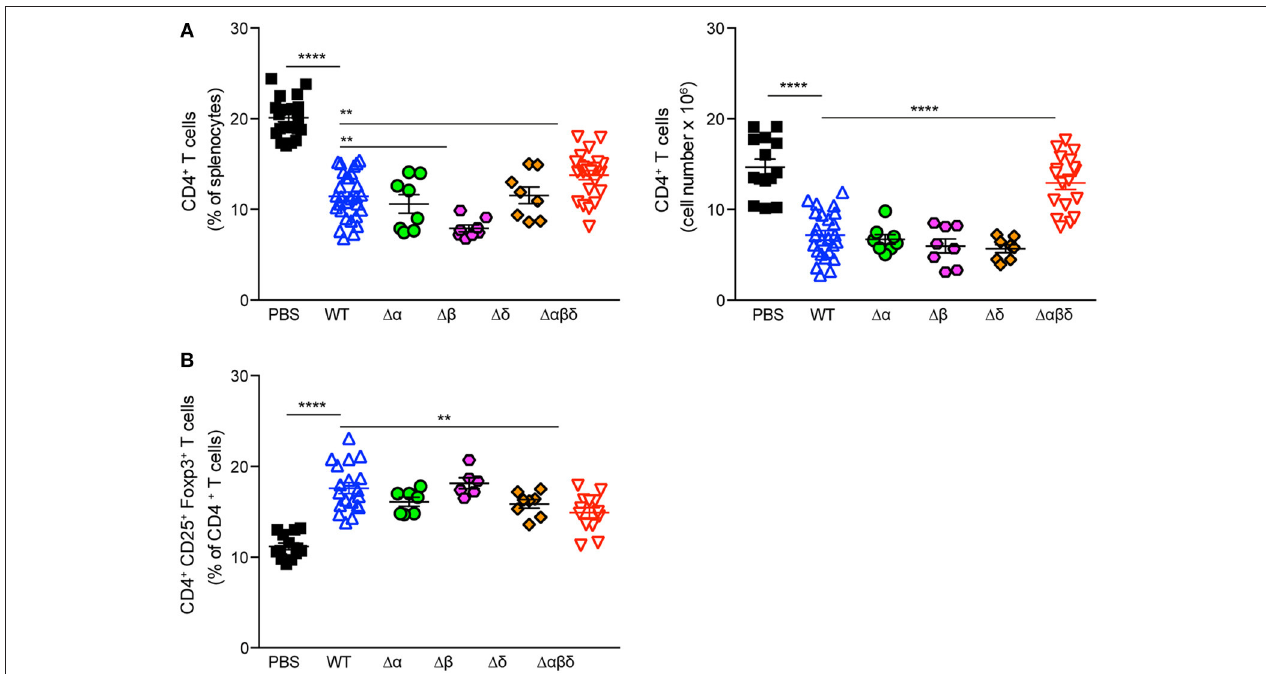
FIGURE 5 | PSM α and δ peptides impair CD4 + T cell and promote T reg responses. Foxp3-eGFP mice were either treated with PBS or infected with S. aureus USA300 WT or the indicated PSM-deletion mutant strains for 3 days and splenocytes were analyzed for CD4 + T cells by flow cytometry. Graphical summary of the frequency and cell numbers of splenic CD4 + T cells (A) and the frequencies of CD4 + CD25 + Foxp3 + T cells among CD4 + T cells (B) . Every symbol represents one mouse. The graphs represent the mean ± SEM with data pooled from multiple experiments; quantity of mice and experiments per condition and time is depicted in Table S2 (one-way ANOVA followed by Tukey’s post-hoc test; differences are just shown compared to the USA300 WT; ** p < 0.01, **** p < 0.0001).